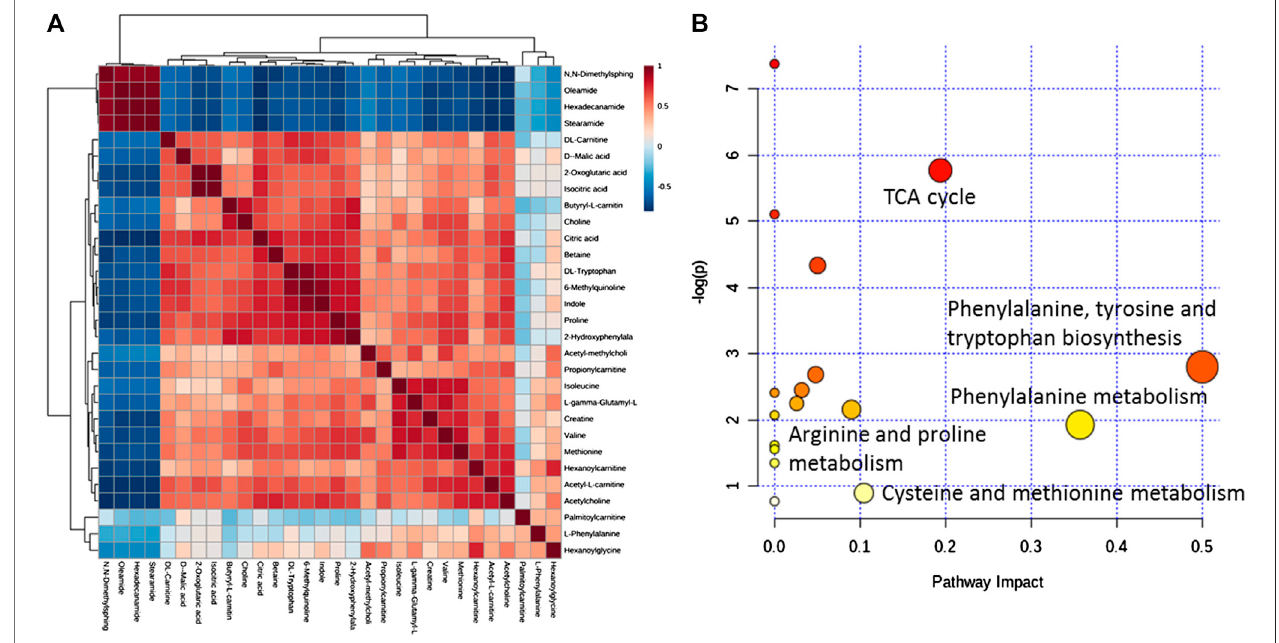
FIGURE 10 | Correlation analysis of differential metabolites in mouse serum (A) . MetPA analysis of metabolic pathways (B) .